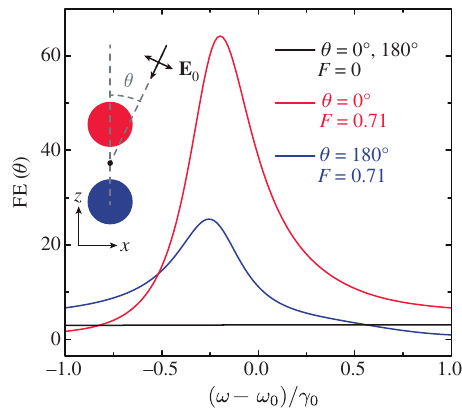
Figure 4: Analysis of the directionality of the field intensity enhancement. Field intensity enhancement, FE( θ ), at the centre of the dimer gap when the system is illuminated with a plane wave. As shown in the inset, we assume the plane wave to propagate toward the dimer at an angle θ and to be polarised parallel to the xz plane. The colour curves display the results for an active–passive dimer with F = 0.71 when θ = 0 ° (red curve) and θ = 180 ° (blue curve), whereas the black curve indicates the results for a completely passive dimer (i.e. F = 0). Notice that, in this case, the results for θ = 0 ° and θ = 180 ° are identical.